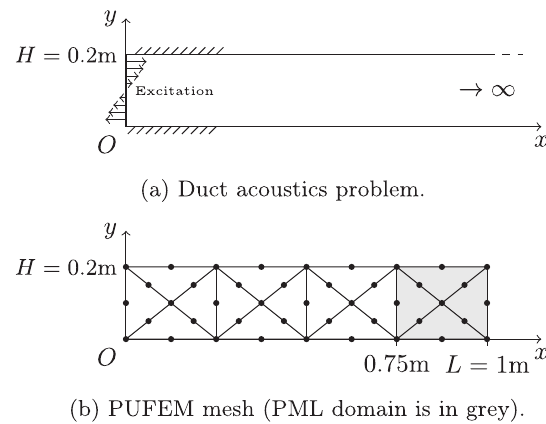
Figure 4. Semi-in fi nite duct con fi guration.